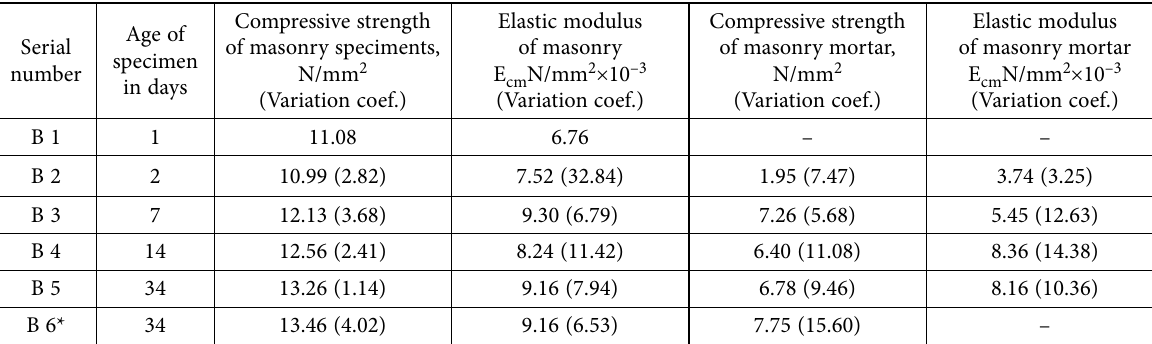
Table 1. The samples parameters and test results